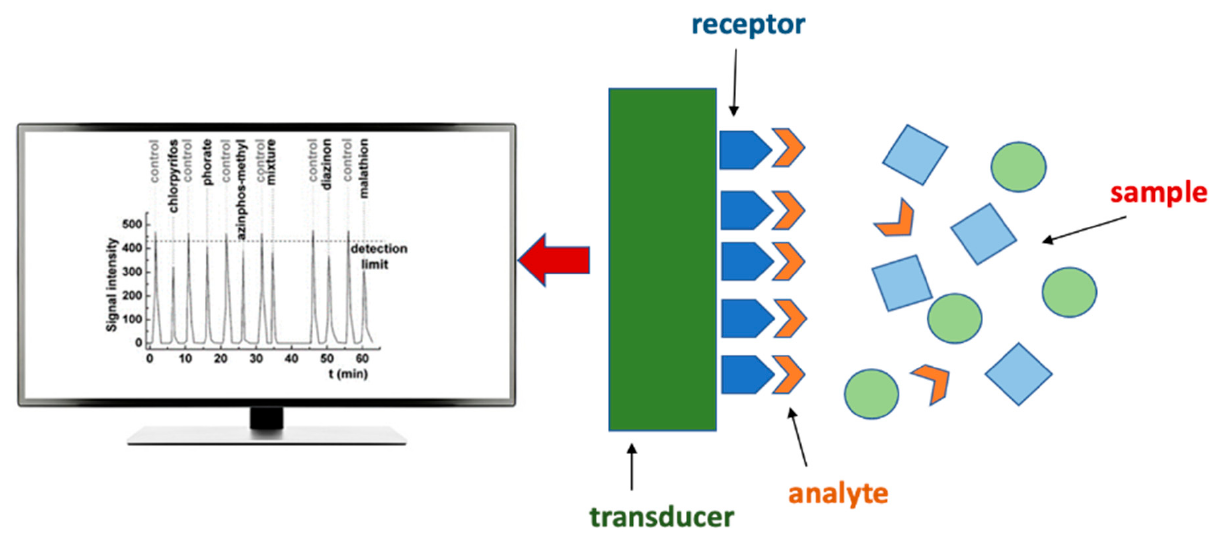
Figure 1. Schematic representation of typical sensor components.